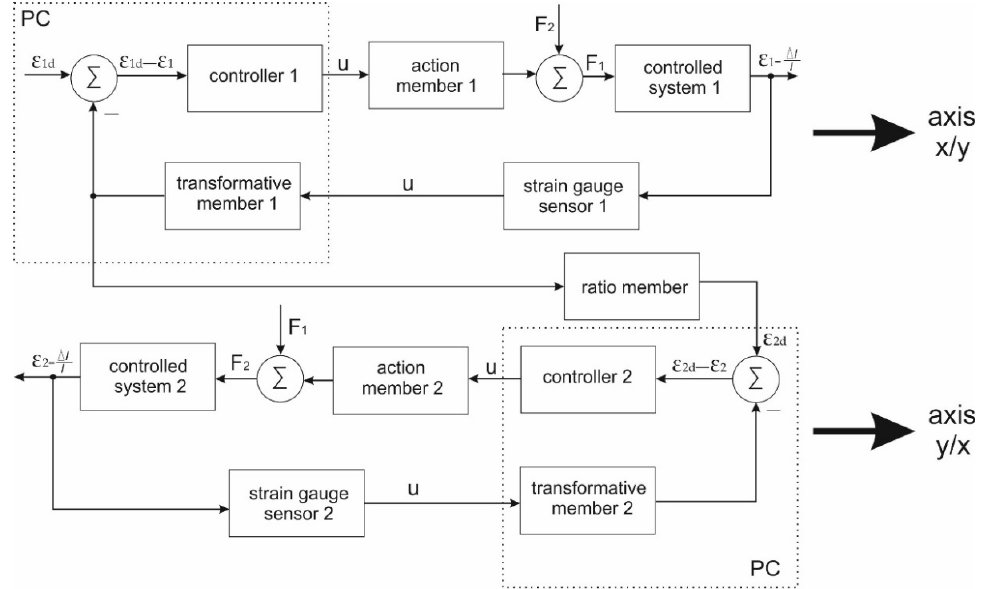
Figure 6. The structure of the closed-loop control circuits.